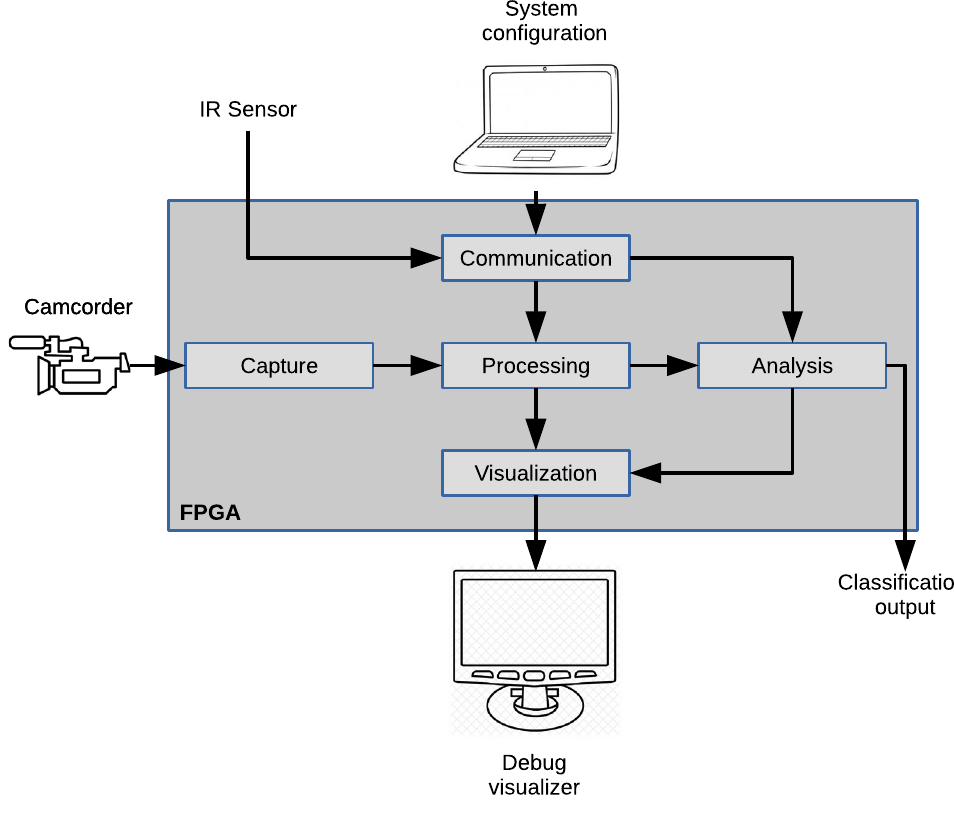
Figure 1. Block diagram of the proposed